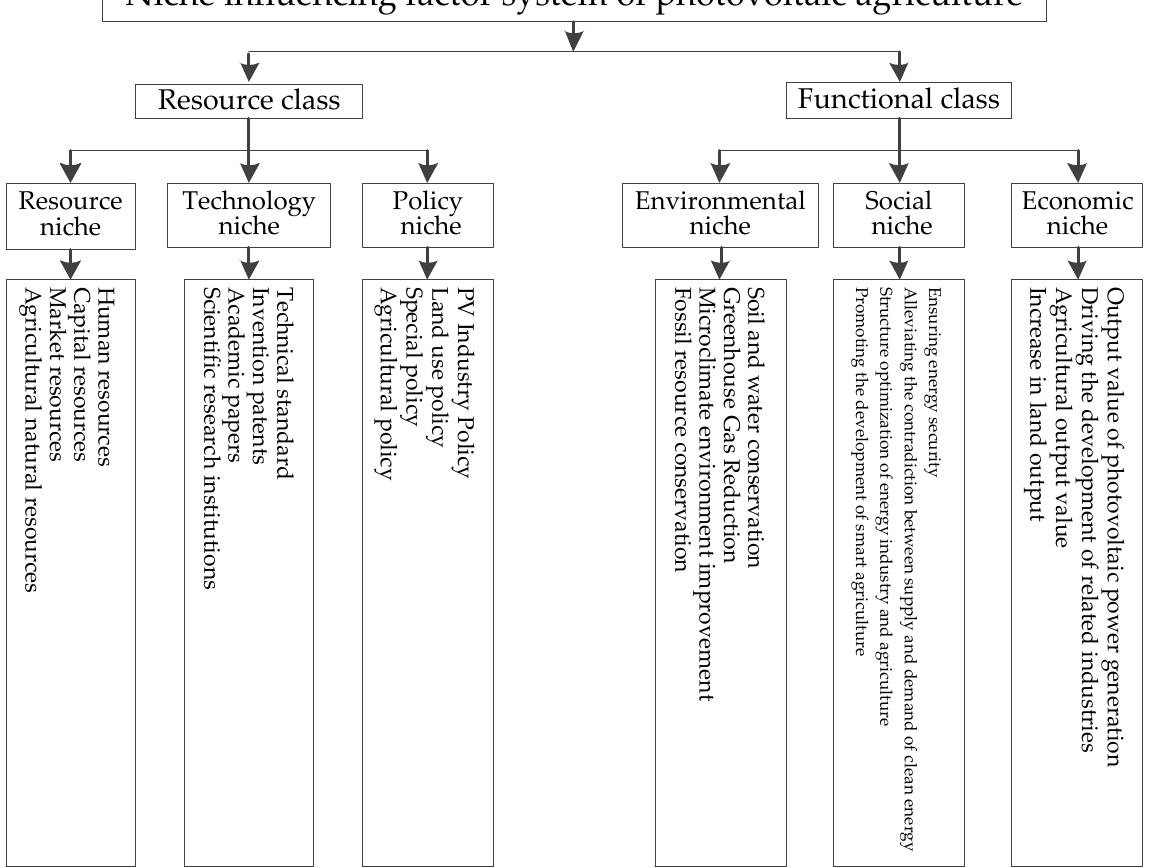
Figure 2. Niche influencing factor system of photovoltaic agriculture.